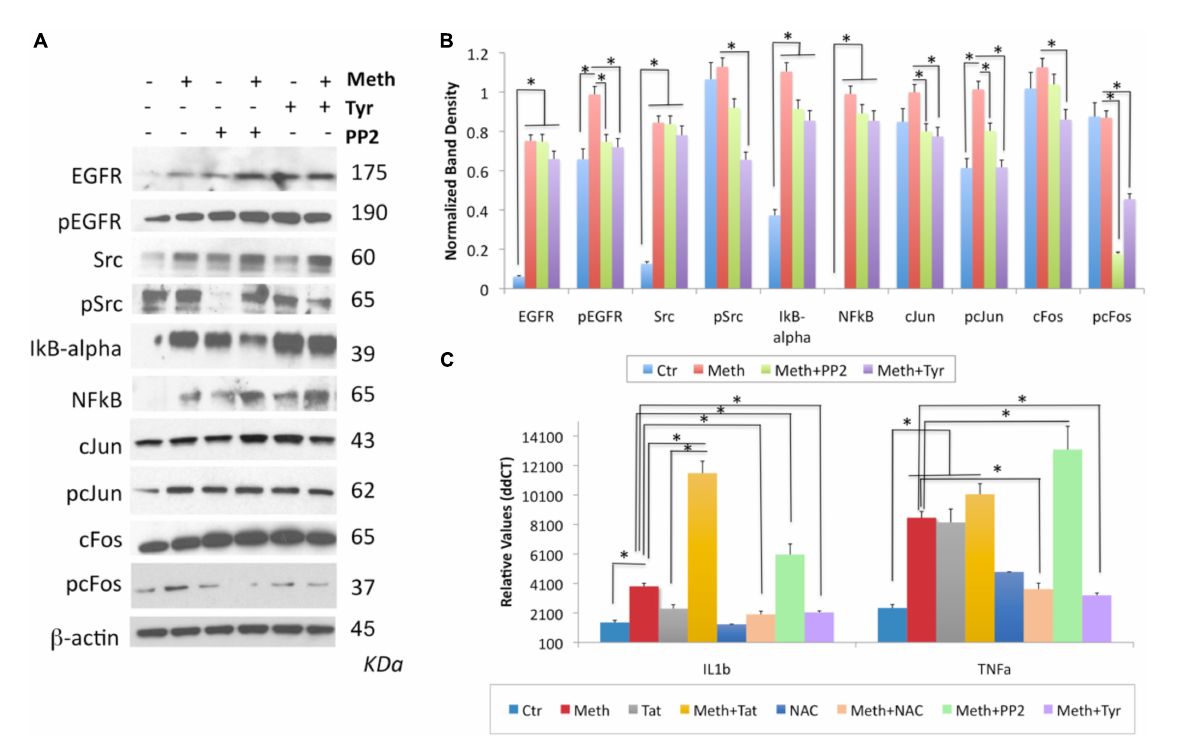
FIGURE11 The contribution of the transactivation of EGFR and its downstream SRC kinase to the induction of IL1 β and TNF α by Meth. The role of EGFR and Src was examined by incubation with pharmacological inhibitors, Tyrphostin (Tyr, 1 uM) and PP2 (1 uM), respectively, added 30 min after Meth (60 uM) was used as stimulus. Western blots were used to confirm the effect of these compounds on the levels of EGFR, pEGFR, SRC, pSRC, cJUN, pcJUN, cFOS and pcFOS, but also whether they have an impact on the IkB-alpha, NFkB pathway, using specific antibodies, all normalized internally with the detection of b-actin. (A) Representative western blots showing all the analyzed transcription factors and the examined conditions. Molecular weight of each band is shown on the right side of the panel. (B) Normalized band density was calculated in Image J, from 2-3 independent experiments. (C) Effect of EGFR and SRC inhibition, as well as of Tat and NAC, on the transcription of IL1 β and TNF α . * p < 0.01 in indicated comparisons. Two-way ANOVA followed by Bonferroni’s